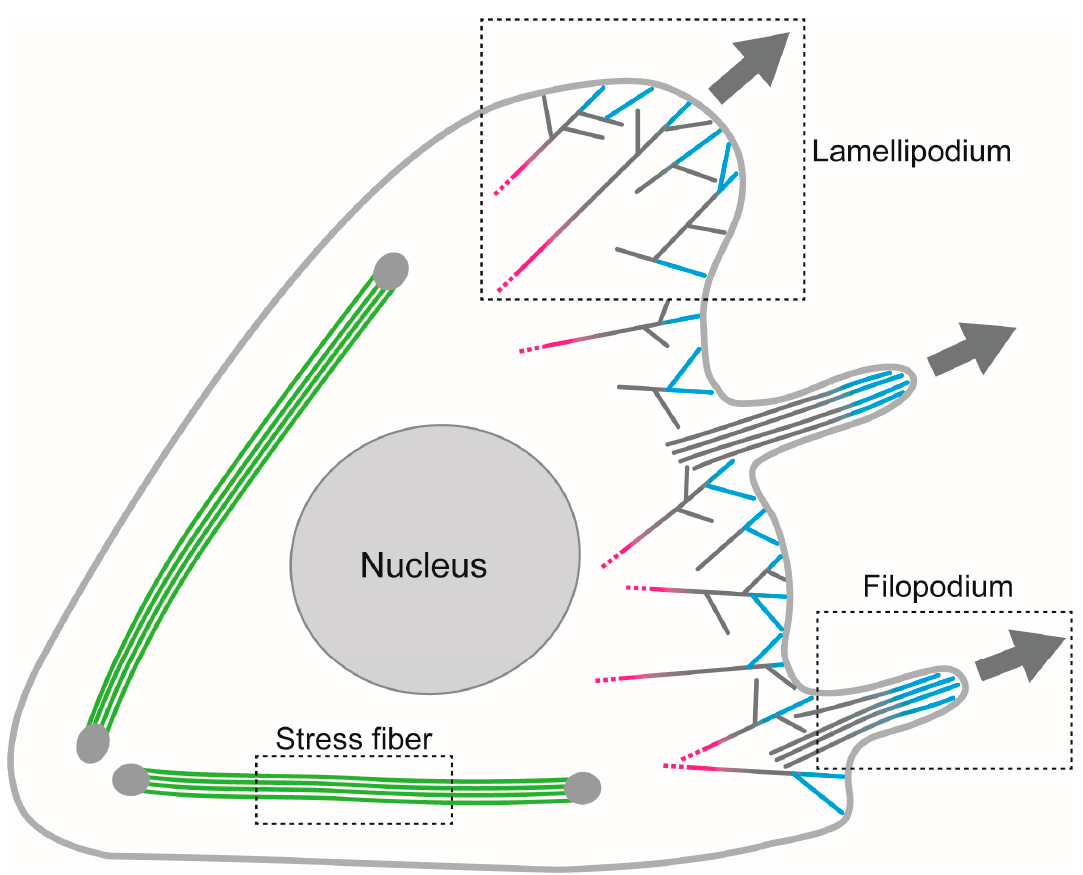
Figure 1. Possible contribution of allosteric interaction between actin-binding proteins (ABPs) and actin filaments to the formation and functions of actin-based machineries, including stress fiber, lamellipodium, and filopodium. Green filaments indicate actin filaments along which cooperative structural changes are evoked by myosin II. Blue filaments in lamellipodium and filopodia are polymerized by formin bound to the barbed end near the cell membrane [78]. Formin would induce a cooperative structural change, but those structural changes do not reach all the way to the pointed ends of filaments (gray sections of the filaments). The binding of cofilin to the gray regions induced another type of structural change (magenta filaments), so that the actin filaments are depolymerized in regions deeper inside the cell. The detailed mechanism driven by cooperative structural changes in actin filaments constituting the stress fibers, lamellipodia and filopodia will be explained in the following sections.